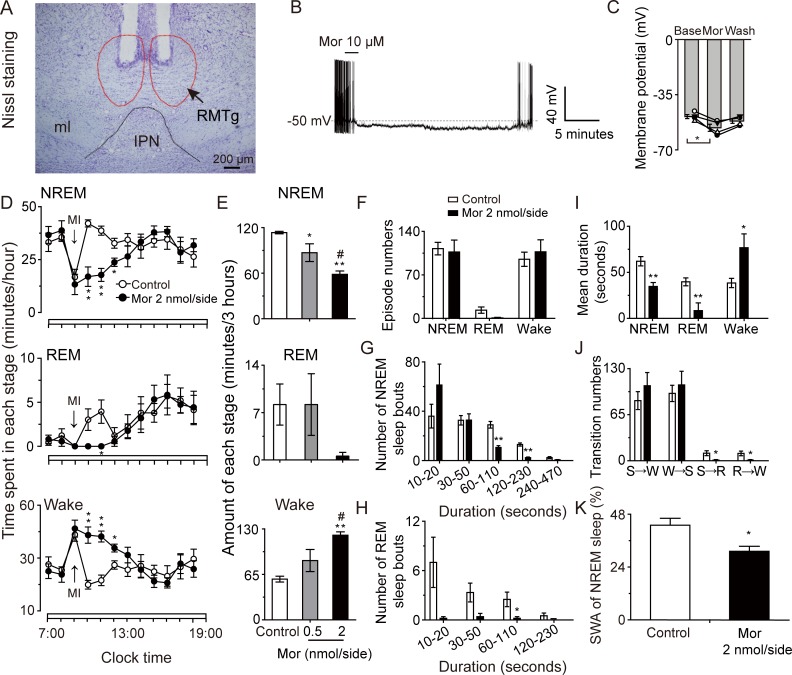
Microinjection of morphine in rat rostromedial tegmental nucleus (RMTg) decreased non-rapid eye movement (NREM) sleep in a dose-dependent manner.(A) Nissl staining showed the implantation sites of the guide cannulas. (B, C) Morphine inhibited RMTg neurons in vitro. A typical trace showed that morphine induced hyperpolarization and inhibited spontaneous firing of a neuron in the RMTg (B) and changes of membrane potentials of RMTg neurons under whole-cell current-clamp with application of morphine. n = 4 cells, *p < 0.05 versus baseline using 1-way ANOVA followed by least significant difference (LSD) (C). (D) Time course of NREM and REM sleep and wakefulness during the light period (07:00–19:00 hours) in rats treated with artificial cerebrospinal fluid (ACSF) or morphine at 09:00 hour. (E) Sleep–wake quantities following ACSF or morphine microinjection in rats during post-injection period (10:00–13:00 hours). *p < 0.05, **p < 0.01 versus ACSF and #p < 0.05 versus 0.5 nmol/side morphine using 1-way ANOVA followed by LSD. (F–K) During the post-injection period (10:00–13:00 hours) after ACSF or morphine microinjection in rats, episode numbers of each stage (F); number of NREM (G) and REM (H) sleep bouts with different duration; mean duration of each stage (I); stage transitions between S (NREM sleep), W (wakefulness), and R (REM sleep) stages (J); and slow-wave activity (SWA) of NREM sleep (K). *p < 0.05, **p < 0.01 versus ACSF using unpaired t tests. MI, microinjection; Mor, morphine. ACSF (n = 6); morphine 0.5 nmol/side (n = 5); morphine 2 nmol/side (n = 5). The horizontal open bars on the x-axes indicate the 12-hour light period. Underlying data can be found in S1 Data.